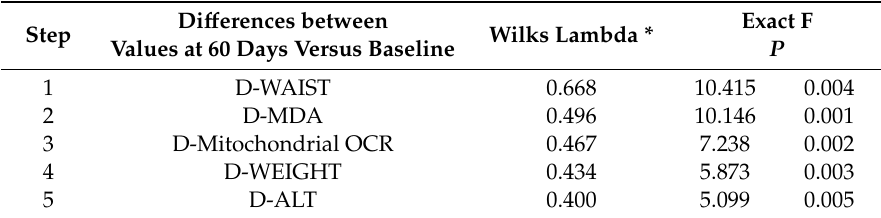
Table 1. Multivariate discriminant analysis showing the best variables able to discriminate RCR from RCR + Tomato groups at the end of the first phase of the trial.